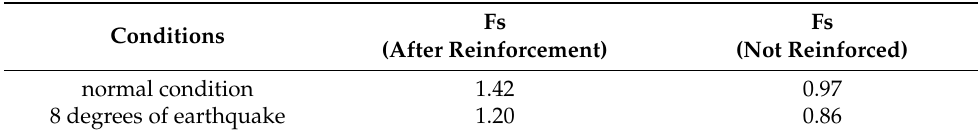
Table 7. Stability coefficient after reinforcement.